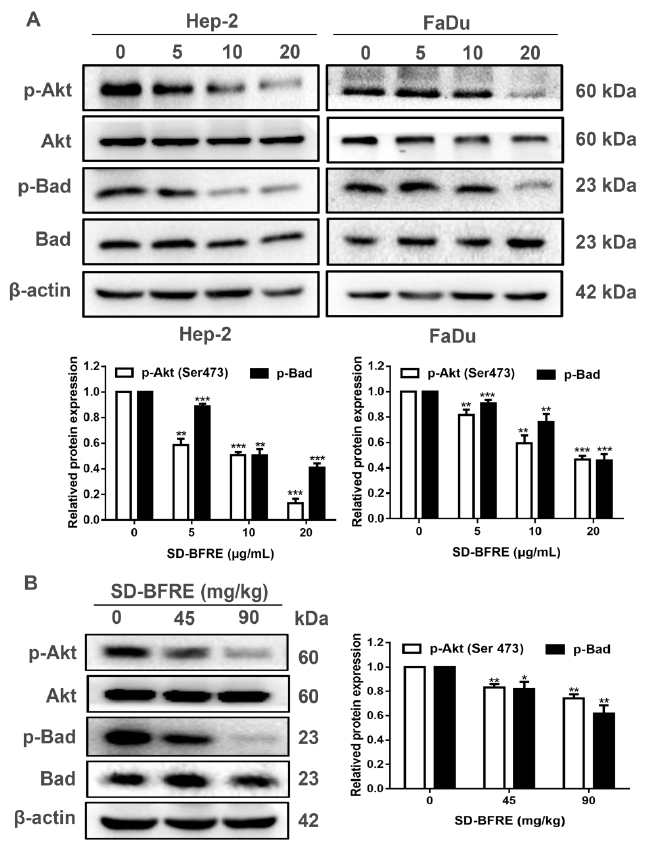
Figure 8. SD-BFRE induces apoptosis by modulating the Akt/Bad pathway in vivo and in vitro. ( A ) The proteins levels of p-Akt, p-Bad, Akt and Bad were detected by Western blot analysis of TC cells after being treated with SD- BFRE (0, 5, 10 and 20 μg/mL). β -actin served as an internal reference. ( B ) Tumor tissue proteins were extracted and prepared, and the relative protein levels of p-Akt, p- Bad, Akt and Bad were detected by Western blot. β -actin served as an internal reference (* p < 0.05, ** p < 0.01 or *** p < 0.001, compare to 0 μg/mL or 0 mg/kg).